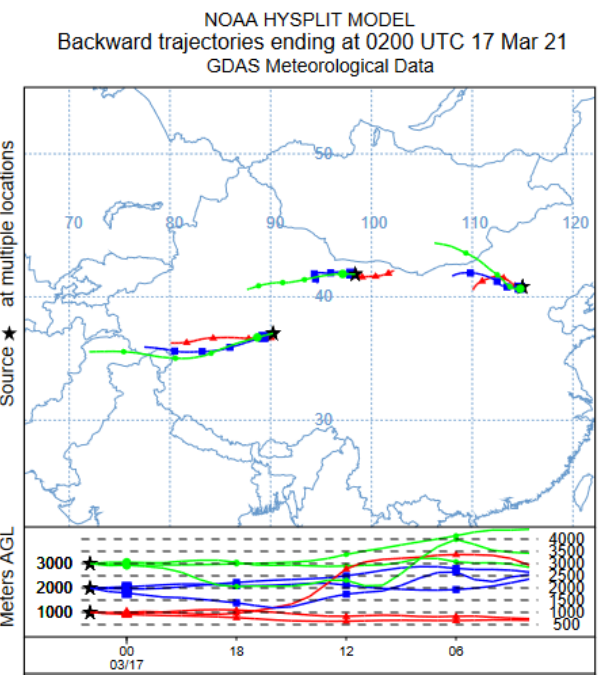
Figure 18. HYSPLIT 24 h backward trajectory for different dust detections in dust storms on 17 March 2021 by day.